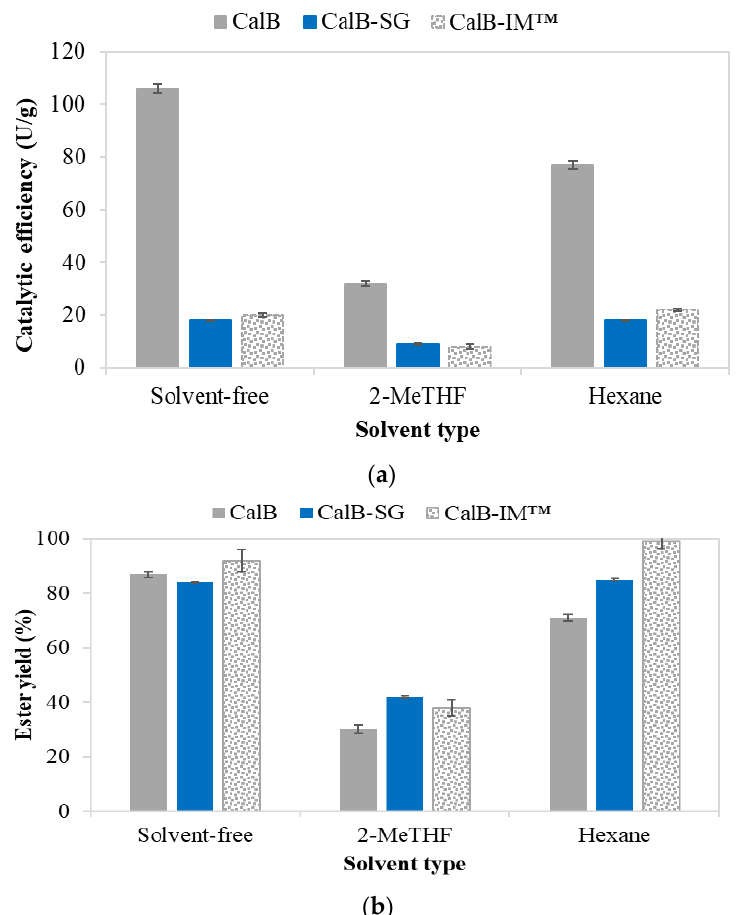
Figure 5. Influence of the reaction medium on the catalytic efficiency ( a ) and ester synthesis yield ( b ) of n -amyl caproate at 36 °C, catalyzed by Candida antarctica lipase B (CalB — native lipase; CalB- SG — sol-gel-entrapped CalB lipase).